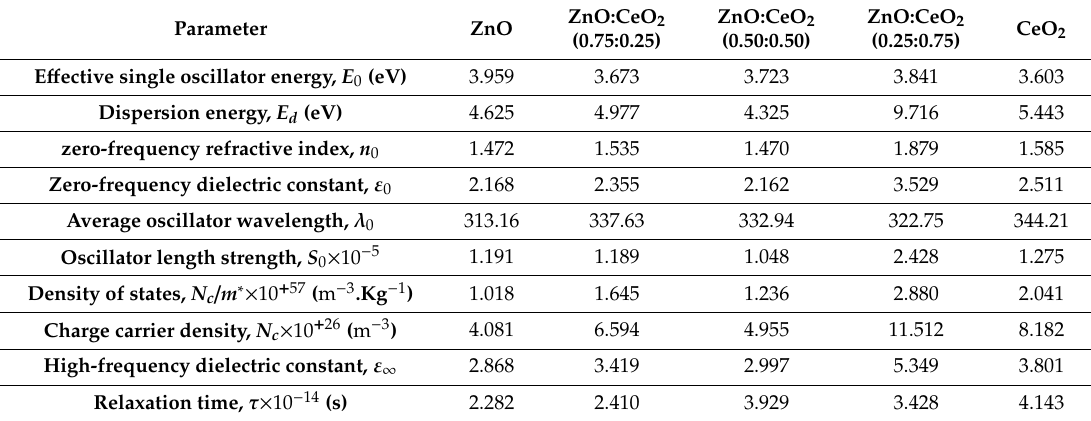
Figure 11. ( a ) (𝑛 (cid:2870) − 1) (cid:2879)(cid:2869) versus (ℎ𝑣) (cid:2870) , ( b ) (𝑛 (cid:2870) − 1) (cid:2879)(cid:2869) versus 𝜆 (cid:2879)(cid:2870) , ( c ) 𝑛 (cid:2870) versus 𝜆 (cid:2870) and ( d ) 𝜀′′ versus 𝜆 (cid:2871) of pure ZnO, pure CeO 2 and ZnO:CeO 2 mixed oxides thin films. Table 2. Estimation of some essential optical parameters of the pure ZnO, pure CeO 2 , and ZnO:CeO 2 thin films for various CeO 2 concentrations.